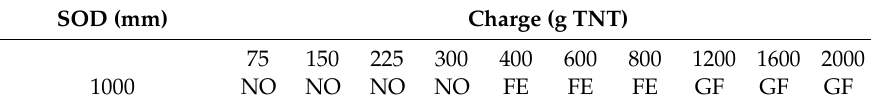
Table 19. Response of UHPFRCC plates to blast loads at 1000 mm stand-off distance (SOD). SOD (mm)